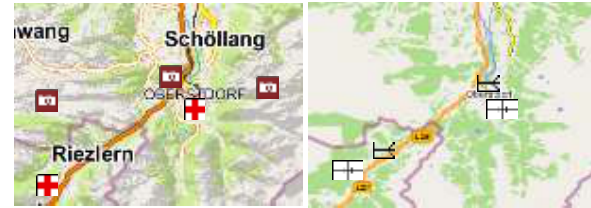
Figure 4: Map layout adapted to role and task Each of the above-mentioned user groups (military, civil security) can simultaneously work with the same data from the same data source on their own device. Generic SLDs in combination with database views are realized for a wide range of different types of vector data. This includes both free, civil and military geodata. This can be topographical data, but also sea and airspace data. All user styles are also adapted to the resolution of the display device. For example, fewer details have to be shown at lower resolution density (see Figure 5). The implementation is made by a points account. The more detailed the geo-object is, the more points are consumed (see local roads to highways). In contrast, high-resolution hardware has more points available than low-resolution hardware.